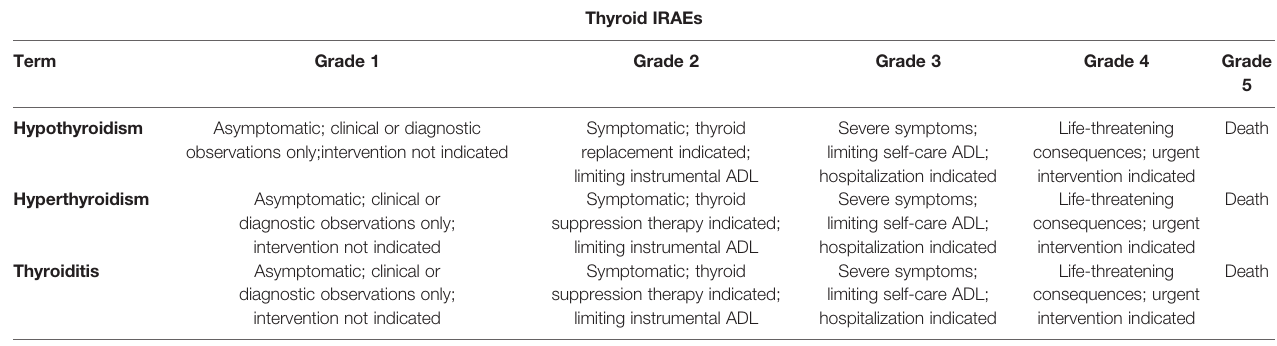
TABLE 2 | Thyroid IRAEs grade in the CTCAE Version